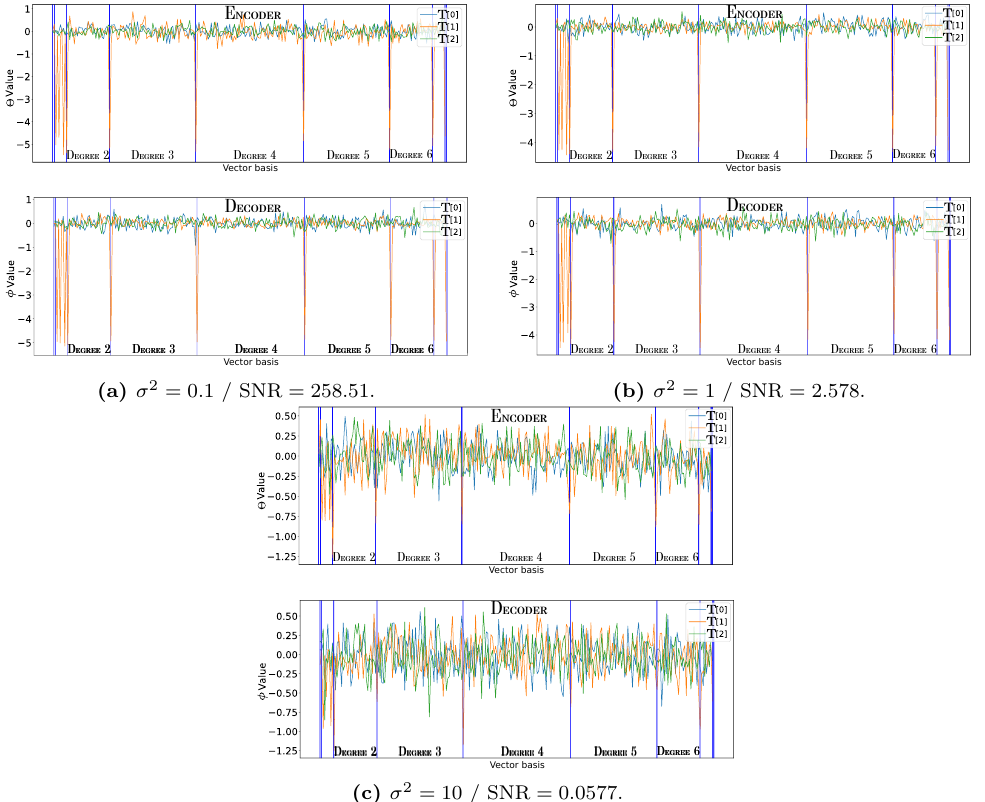
Figure 9: Weight visualization of the ˆ ψ Θ layer (encoder) and the ˆ ψ φ layer (decoder) for Scenario 1